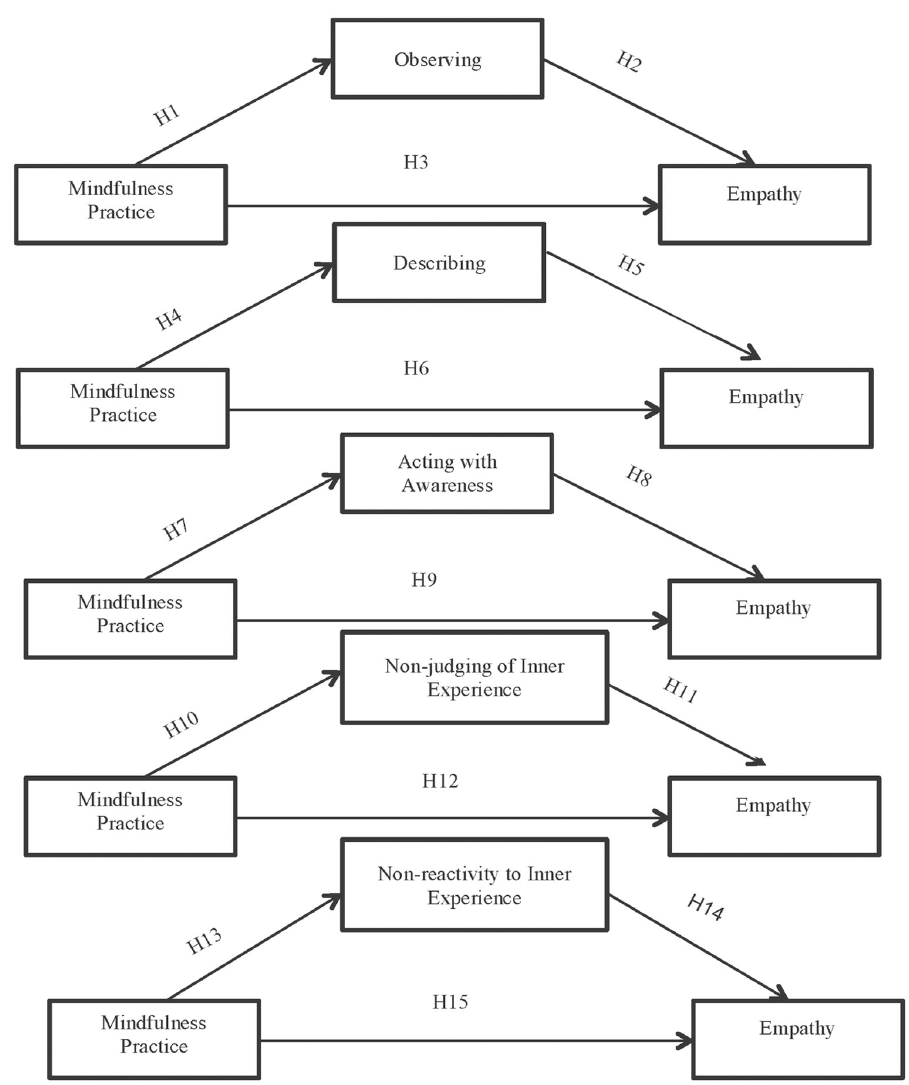
Fig 3. Hypothesized mediation model: Indirect effect of mindfulness practice on empathy through each mindfulness facets separately (H = hypothesis).